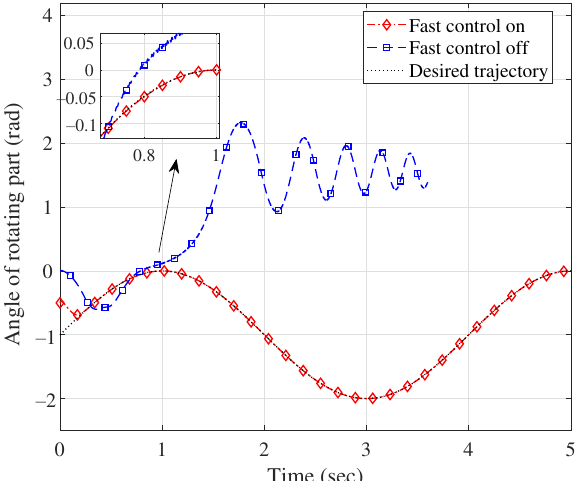
Figure 23. Angle of rotating part (Group 4).